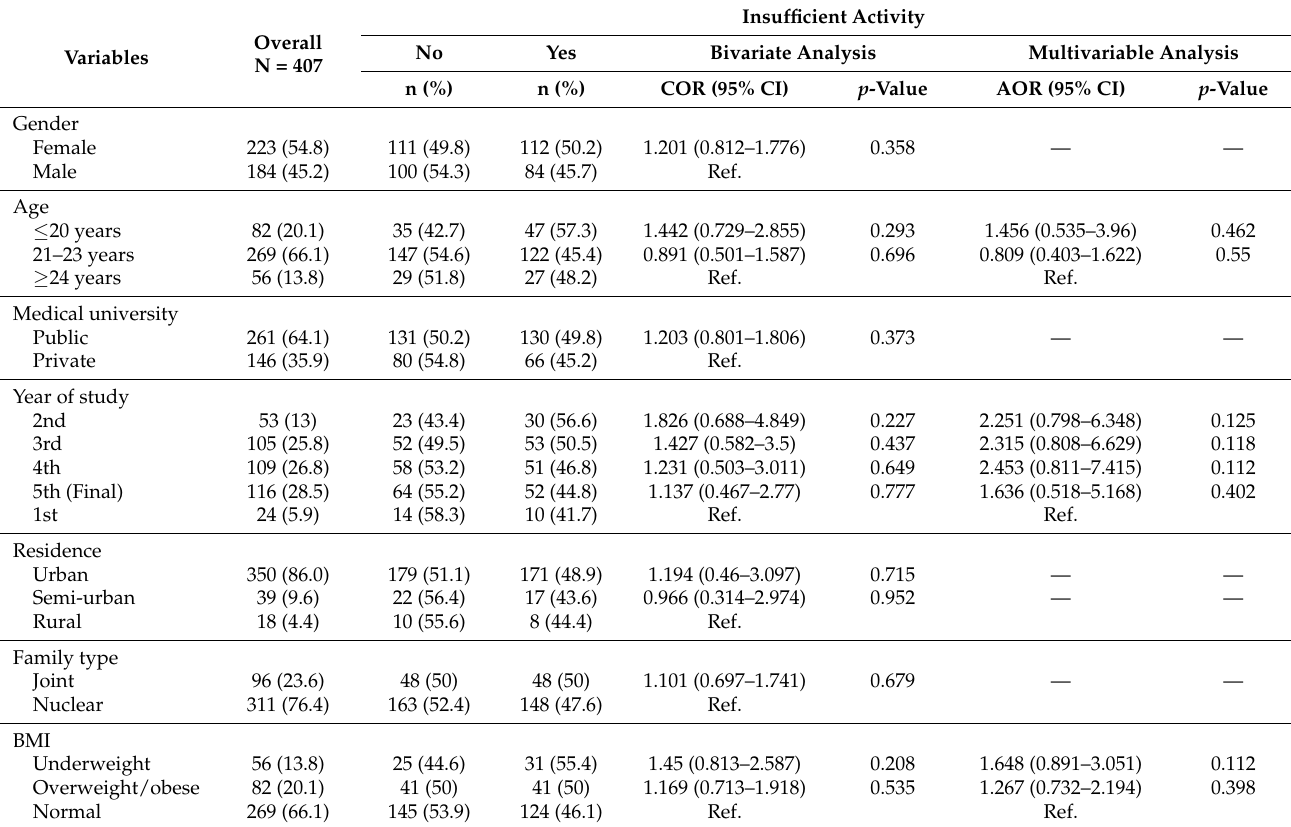
Table 1. Distribution of all variables, and regression analysis predicting insufficient